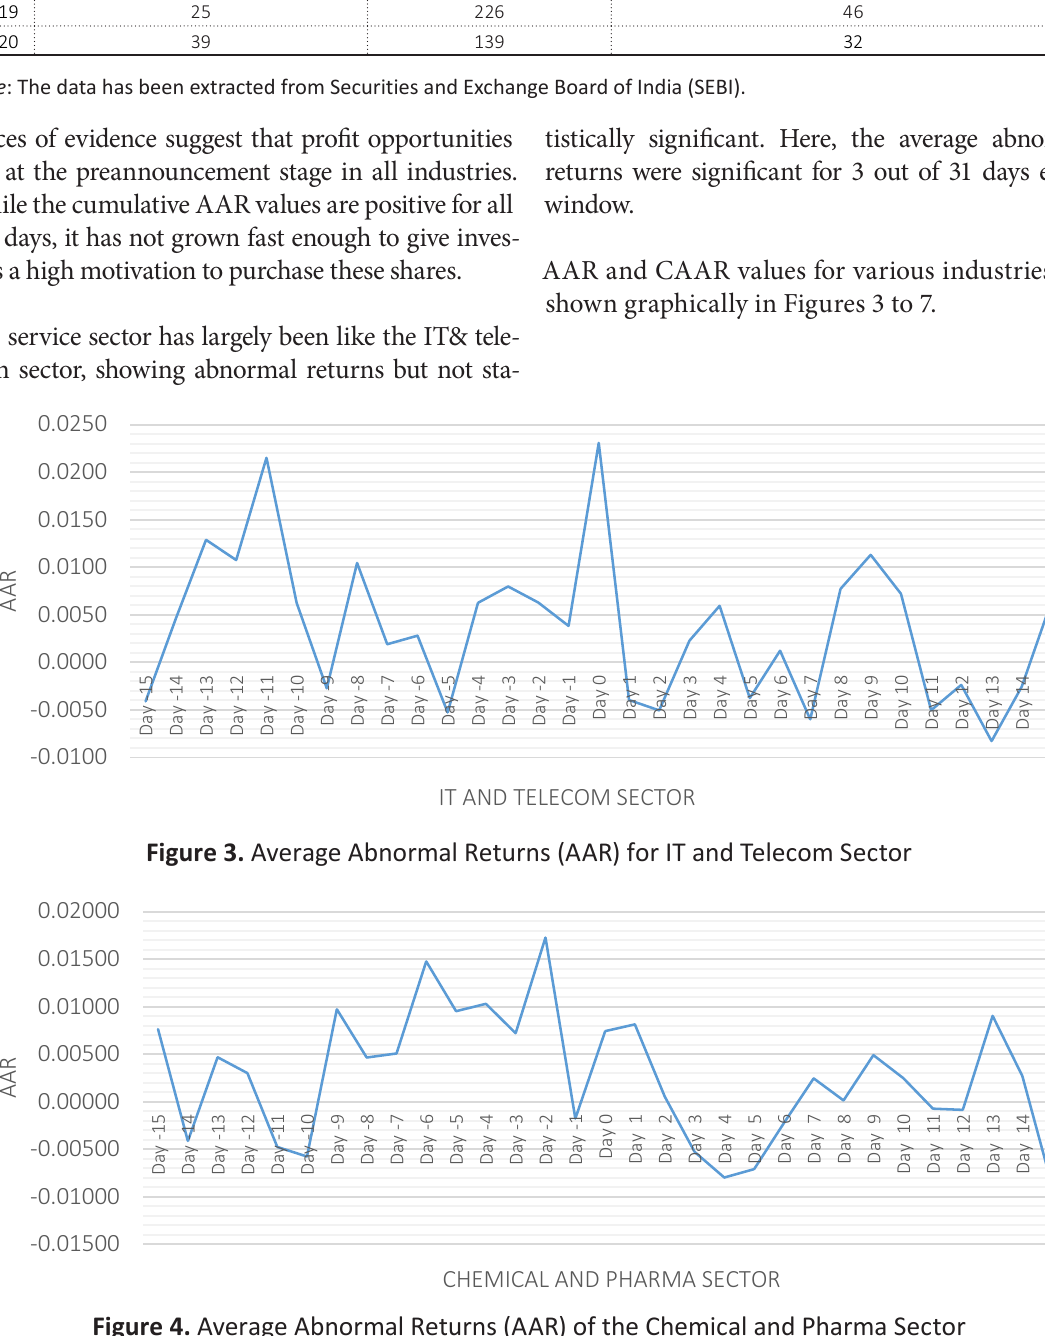
Figure 4. Average Abnormal Returns (AAR) of the Chemical and Pharma